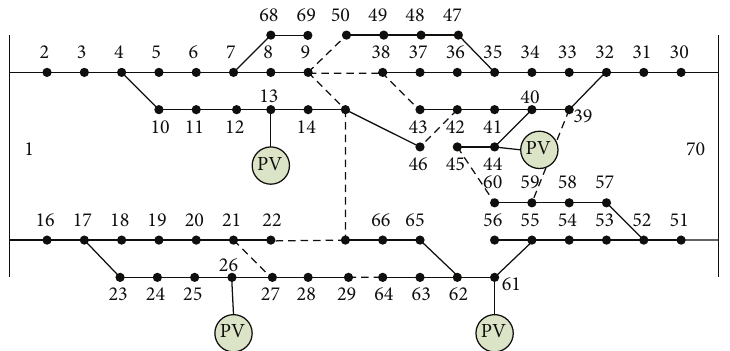
Figure 2: Optimal feeder reconfiguration using the proposed method.